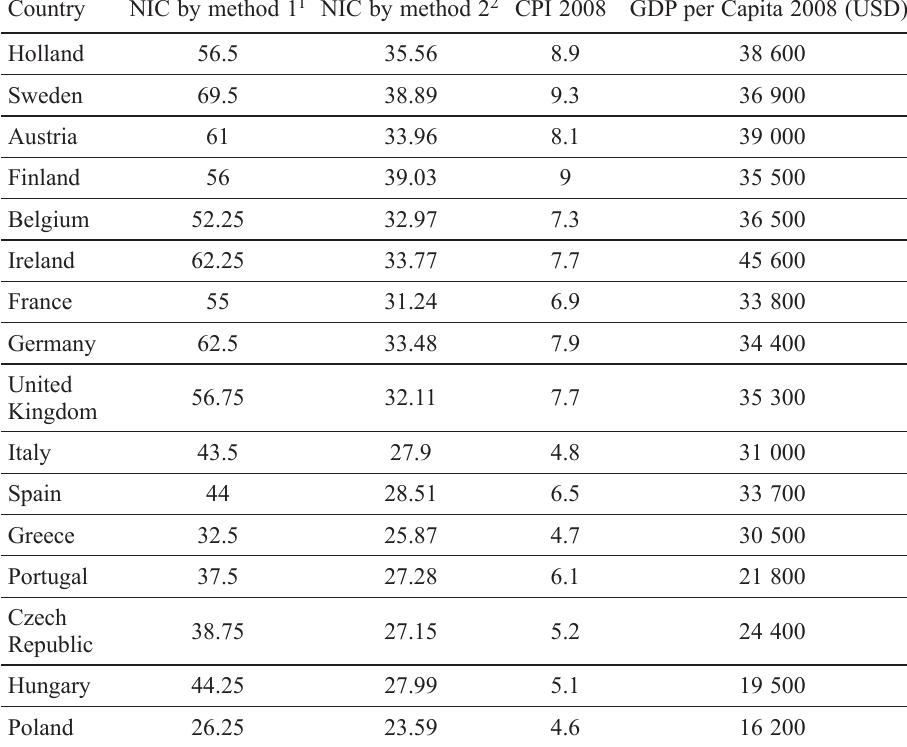
Table 2. National Intellectual Capital within two measurement methods and